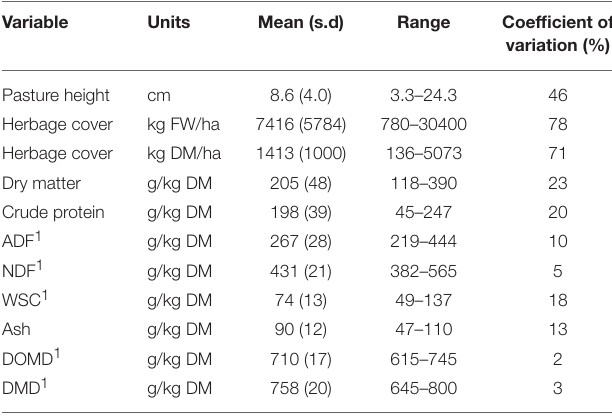
TABLE 4 | Effect of pasture type (permanent or temporary), phase of production (grazed or rested for regrowth), and month of year (April to August) on herbage height, and fresh weight (FW) and dry matter (DM) herbage